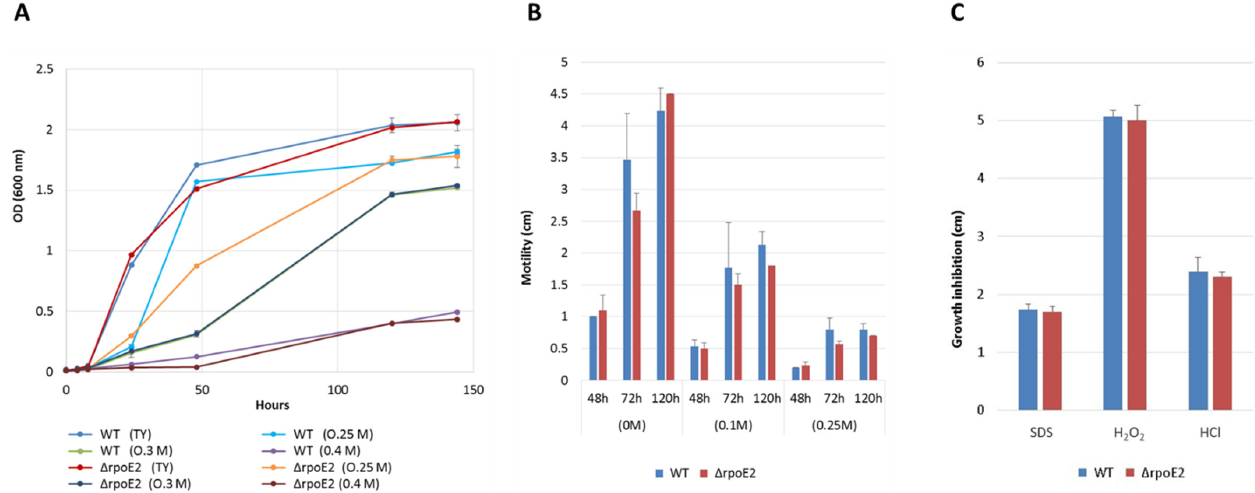
Figure 2. Effect of the rpoE2 mutation on stress tolerance and motility of LMR001. Ensifer aridi LMR001 (WT) and the LMR001 rpoE2 deletion mutant ( Δ rpoE2) growths were compared in liquid TY medium complemented with 0, 0.1, 0.25, 0.3, or 0.4 M of NaCl ( A ). Their motility was assessed in semi-solid TY complemented with salt at 0, 0.1, or 0.25 M by measurement of the diameter of the swimming colonies after 2, 3, or 5 days of incubation ( B ). Finally, the diameters of the growth inhibition zones were compared for the two strains inoculated in top agar plates, to the center of which patches imbued with 5 μ L of SDS (10% w / v ), H 2 O 2 (5.5 M), or HCl (2 M) were placed ( C ). Table 2. Effect of the rpoE2 mutation on symbiosis development with Vachellia . Shoot Weight (g) Root Weight (g) Nodule Number Plant/Treatment Mean Standard Deviation Mean Standard Deviation Mean Standard Deviation